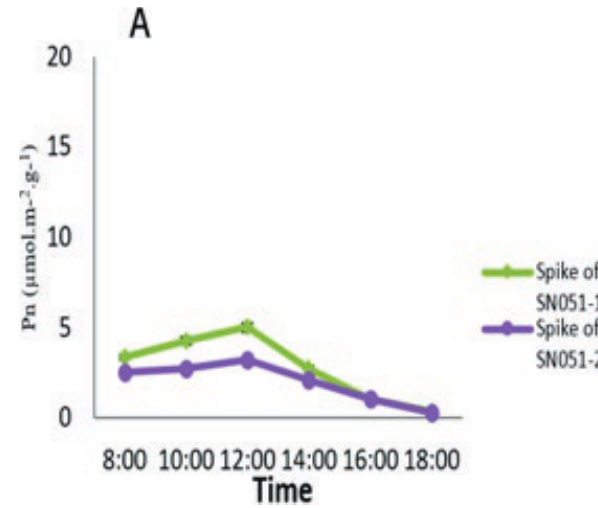
Figure 6. Curve of the daily net photosynthetic rate of flag leaf for SN051-1 and